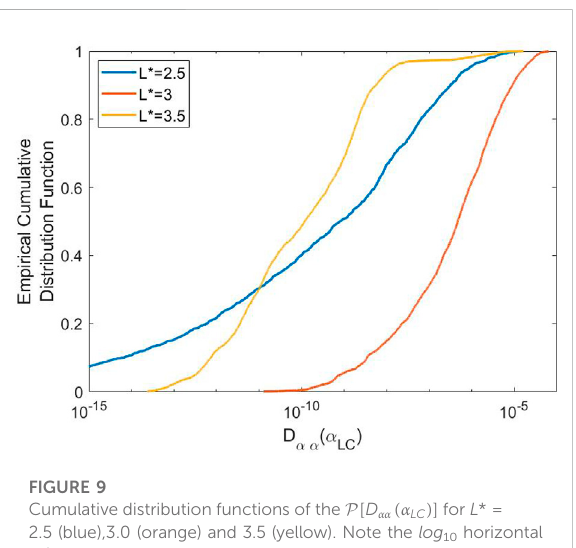
FIGURE 9 Cumulative distribution functions of the P [ D αα ( α LC )] for L * = 2.5 (blue),3.0 (orange) and 3.5 (yellow). Note the log 10 horizontal